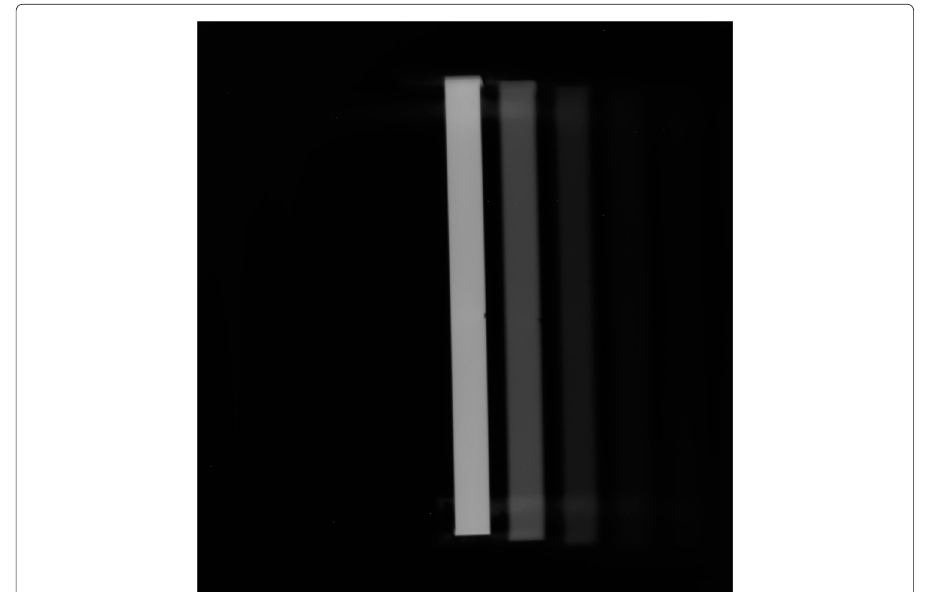
Fig. 2 An image of the calibrated tungsten-strip of the calibration lamp is shown. The weaker signal to the right side, are reflections of that tungsten-strip on slightly tilted neutral density filters. This tilt was deliberately introduced to avoid that these reflections overlay with the original